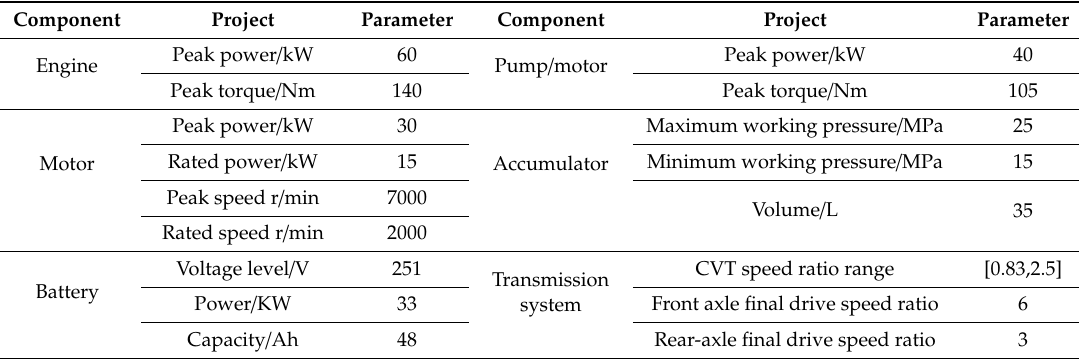
Figure 1. Structure of oil–electric–hydraulic hybrid power system. Table 1. Working modes of the hybrid system.